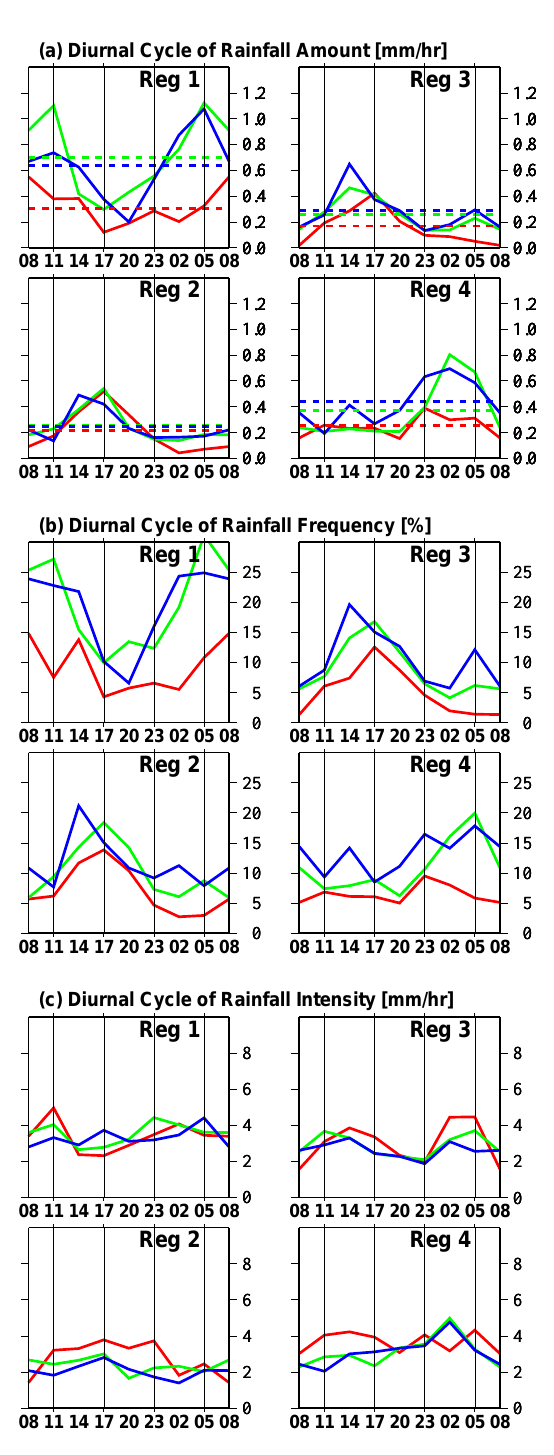
Fig. 3. Diurnal cycle in rainfall amount (a) , rainfall frequency (b) , and rainfall intensity (c) over the four regions. The region was shown in Fig. 1. The Red lines denote that during AM. Green lines show that during JJ, and blue lines indicate that during AS. The dashed lines in (a) indicate the daily mean value of rainfall amount during each period.